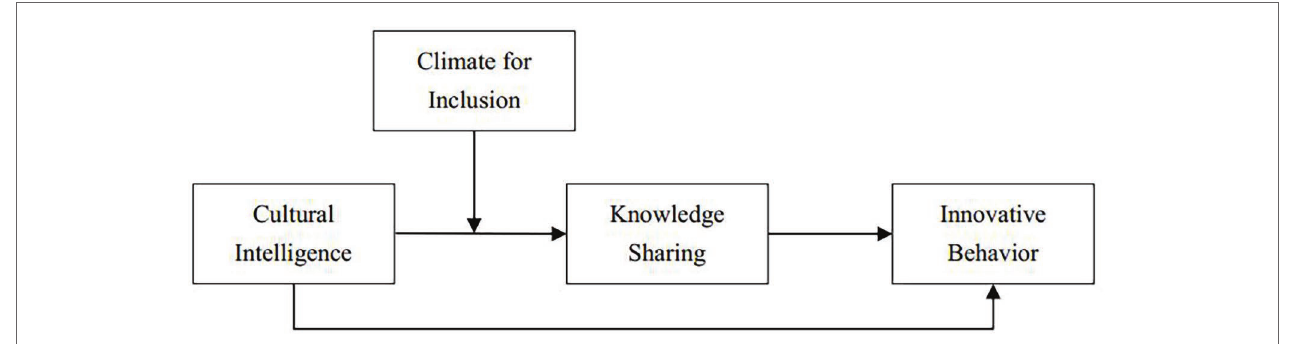
FIGURE 1 | Conceptual